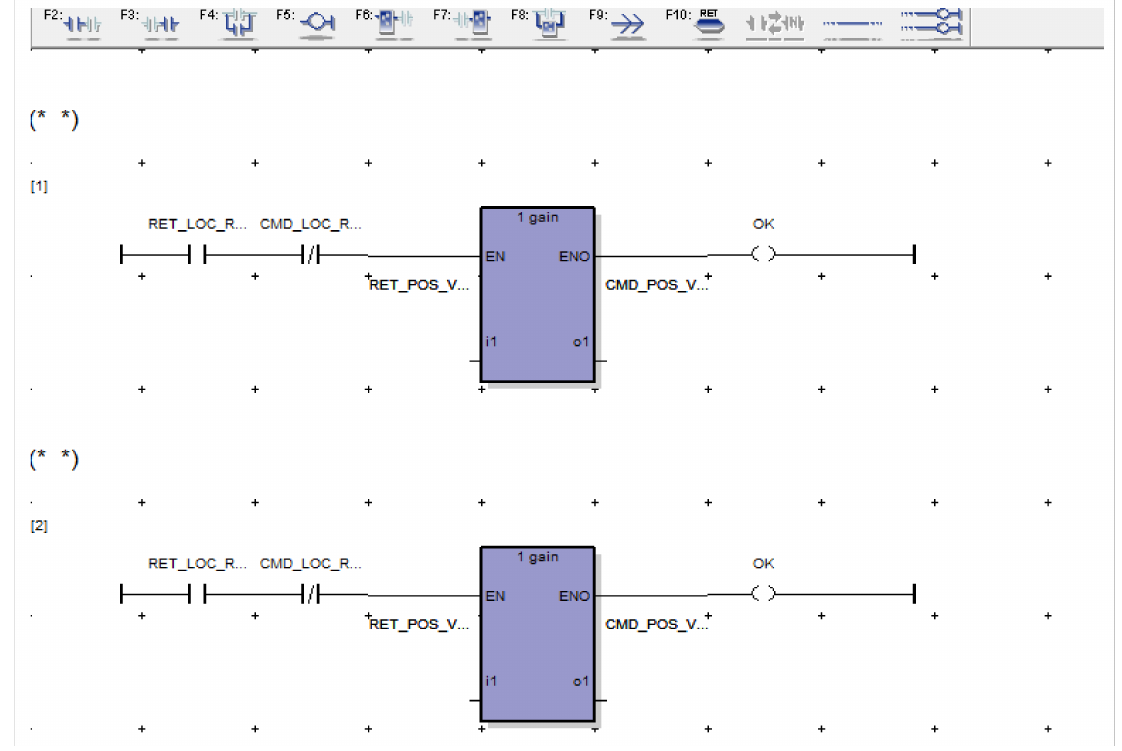
Figure 11. Logic for remote and local status control.